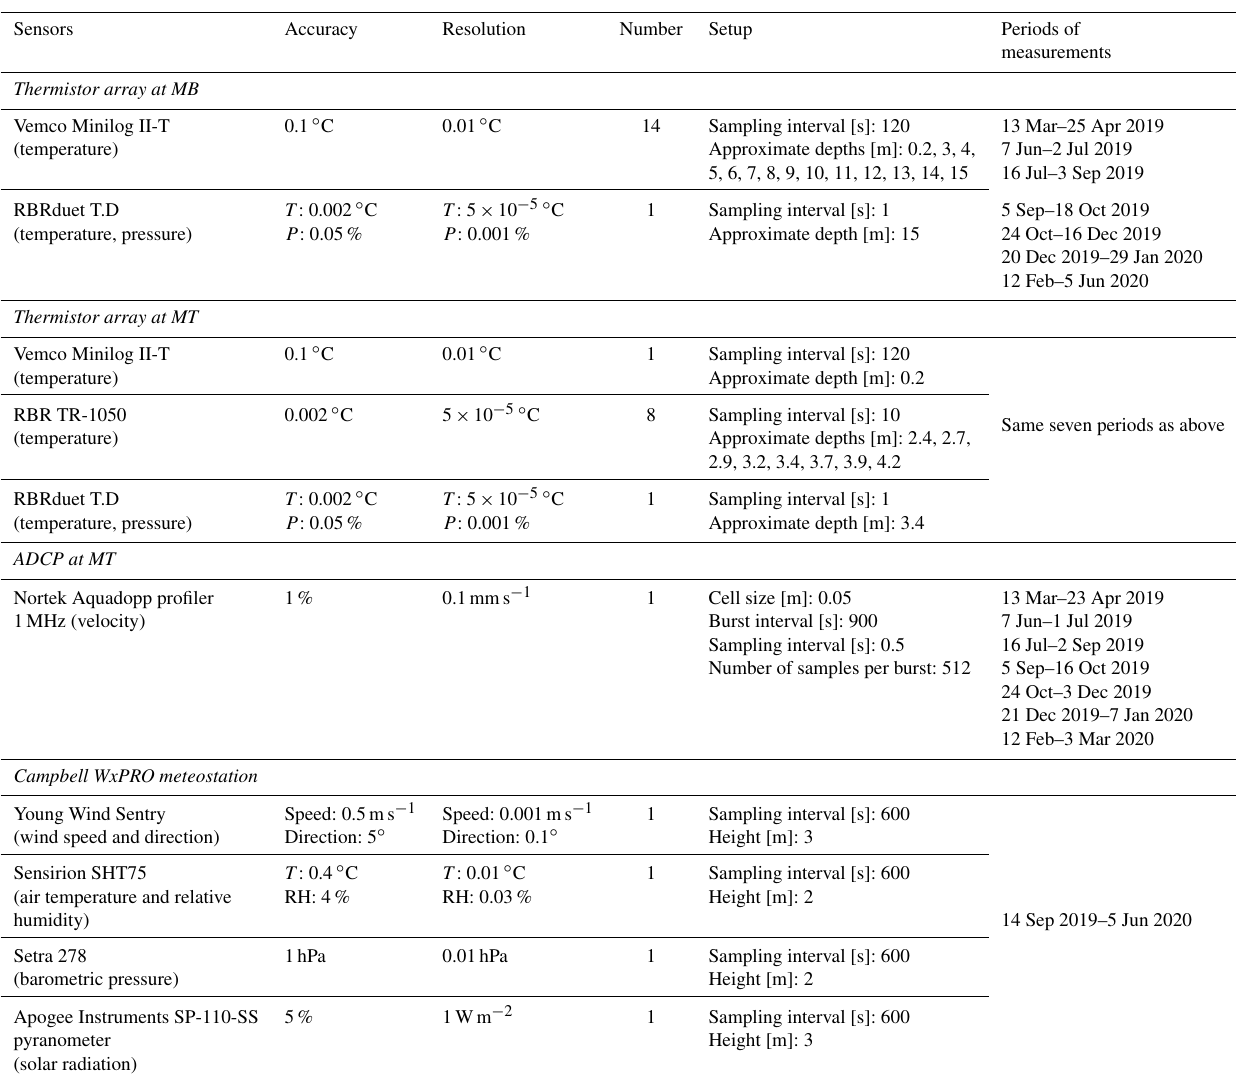
Table A1. Specifications and setup of the sensors from the two moorings and the meteorological station. For the ADCP, only the complete days of measurements used for the transport estimates are taken into account in the measurement